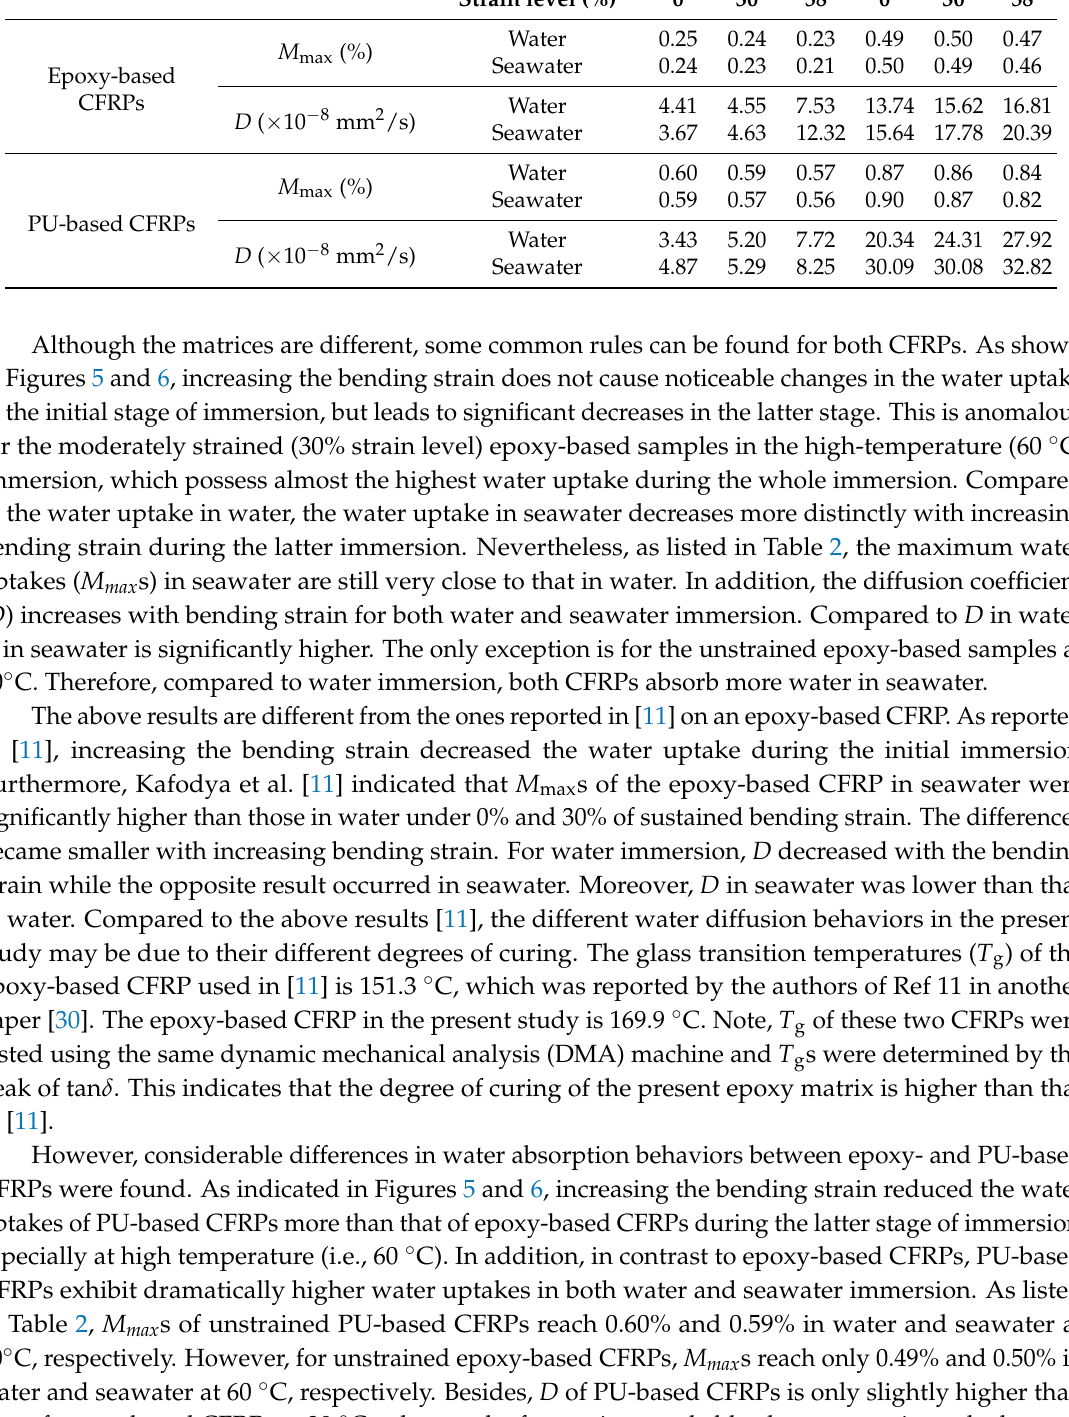
CFRPs Parameters